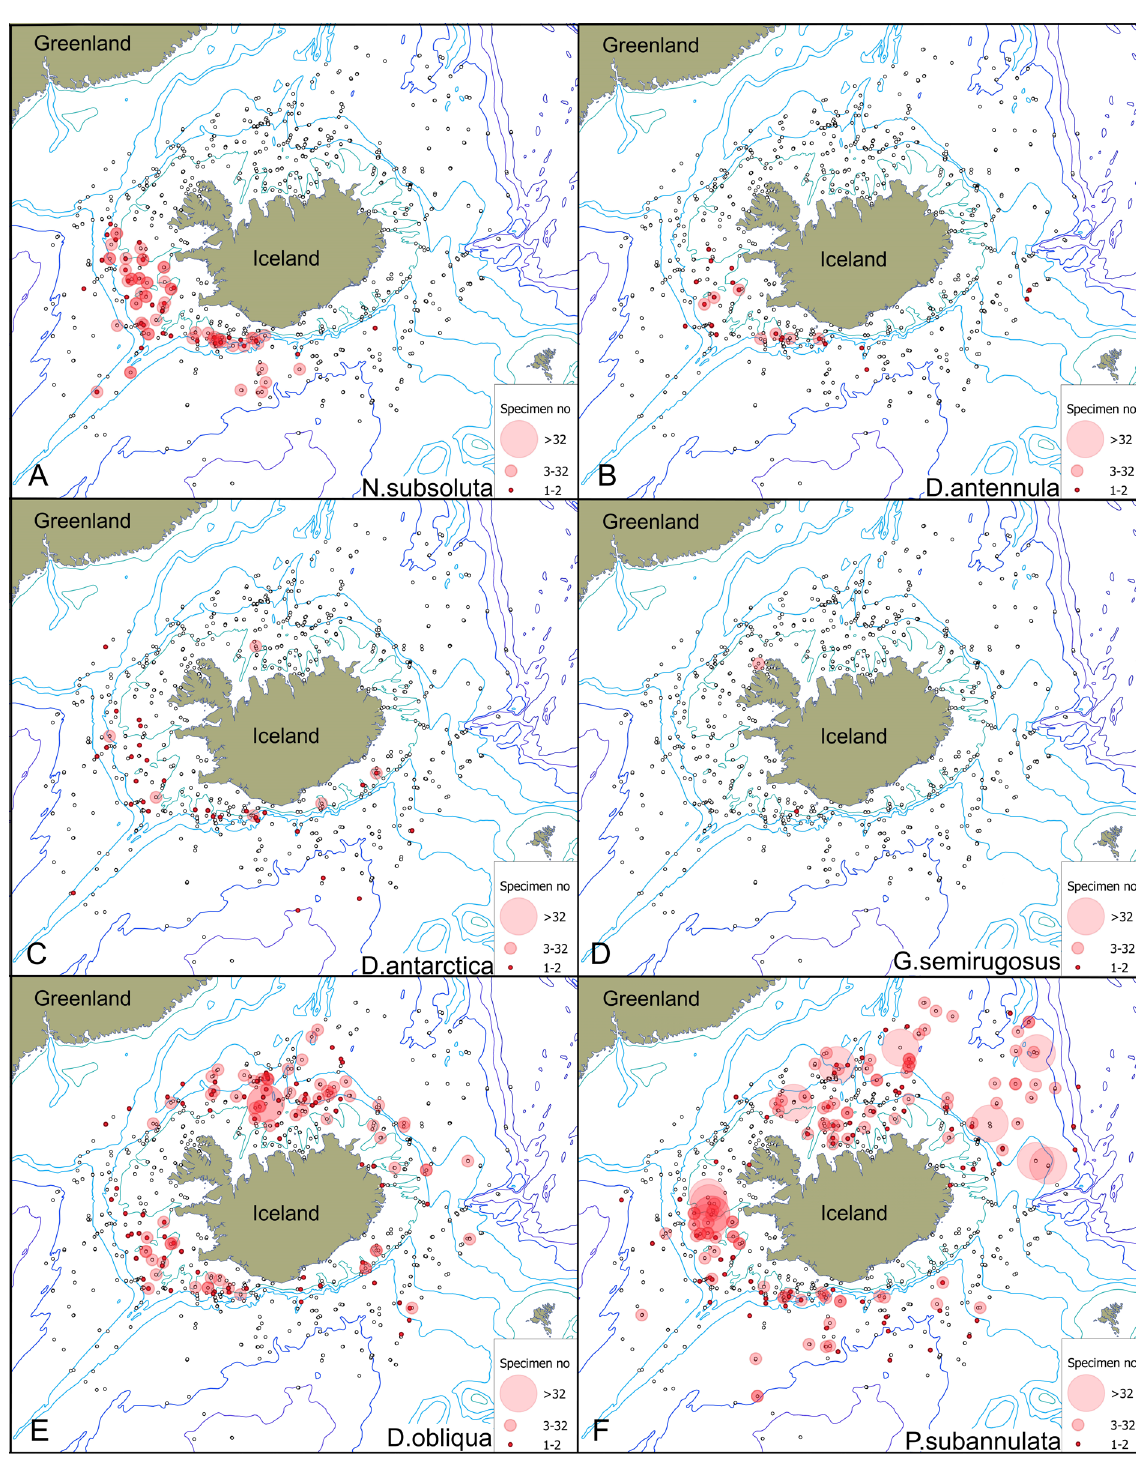
Fig. 20. Species distributions based on BIOICE samples (Icelandic waters). A . Nodosaria